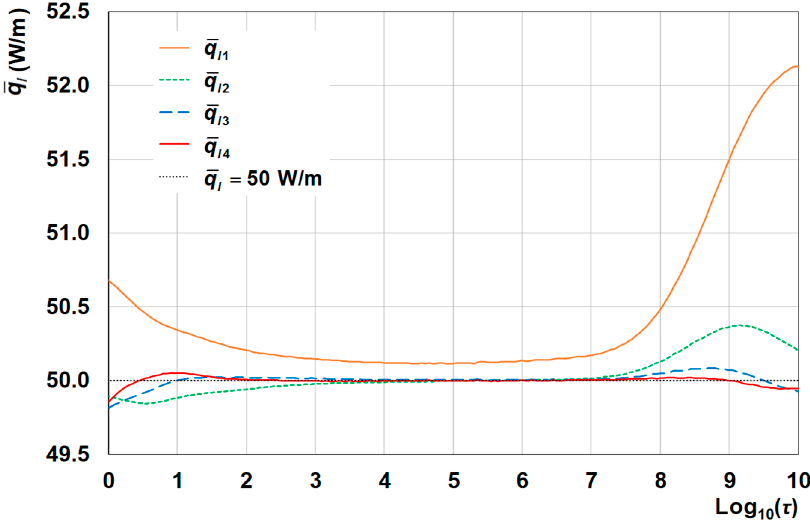
Figure 10. Plots of q versus log 10 ( τ ), for the fluid-to-ground thermal responses θ f 1 , θ f 2 , θ f 3 , θ f 4 , FCS model.